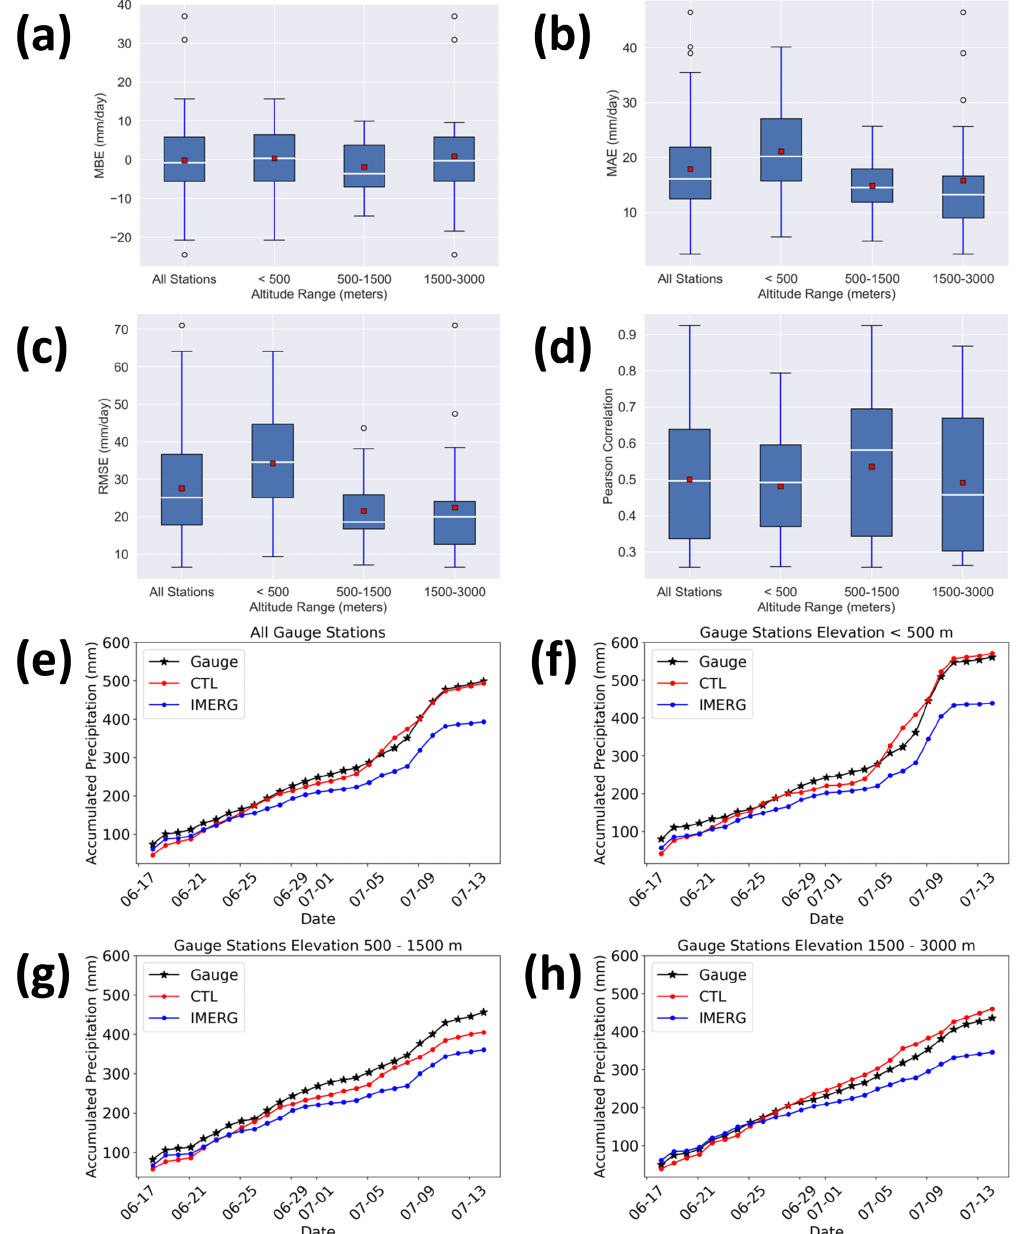
Figure 5. Box plots show the median, interquartile range, and extreme distribution for each of the error statistics – (a) MBE, (b) MAE, (c) RMSE, and (d) Pearson correlation – between the simulated and the rain gauge stations over Nepal, at an altitude that ranges below 500m (41 stations), between 500 and 1500m (28 stations), and between 1500 and 3000m (21 stations). The red color marker at the center of the box represents the mean value. Time series of averaged accumulated precipitation at DHM rain gauge stations, CTL, and IMERG; (e) all rain gauge stations; stations located (f) below 500ma.s.l., (g) between 500 and 1500m, and (h) between 1500 and 3000m terrain